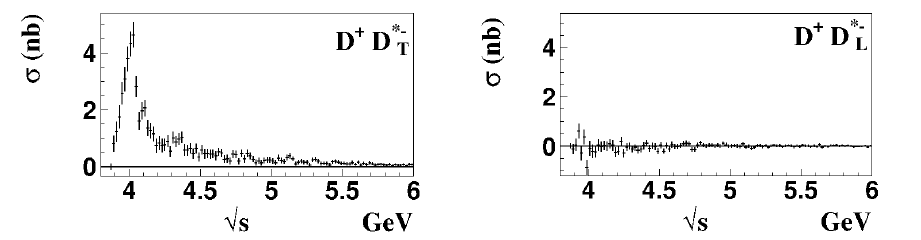
Figure 3. The components of the e + e − helicity: left is transverse; right is longitudinal.